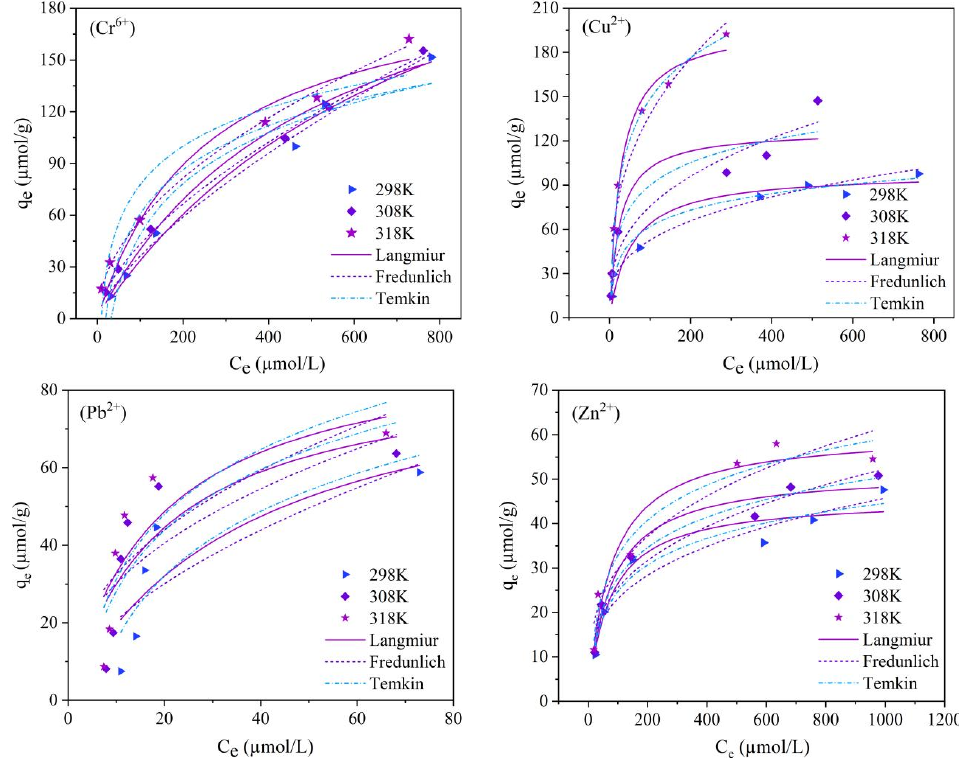
Figure 3. Fitting of Langmuir, Freundlich, and Temkin isotherm models to the adsorption of Cr 6+ , Cu 2+ , Pb 2+ , and Zn 2+ onto magnetic nano-chitosan in aqueous solution. Table 3. Fitting parameters of Langmuir, Freundlich, and Temkin isothermal